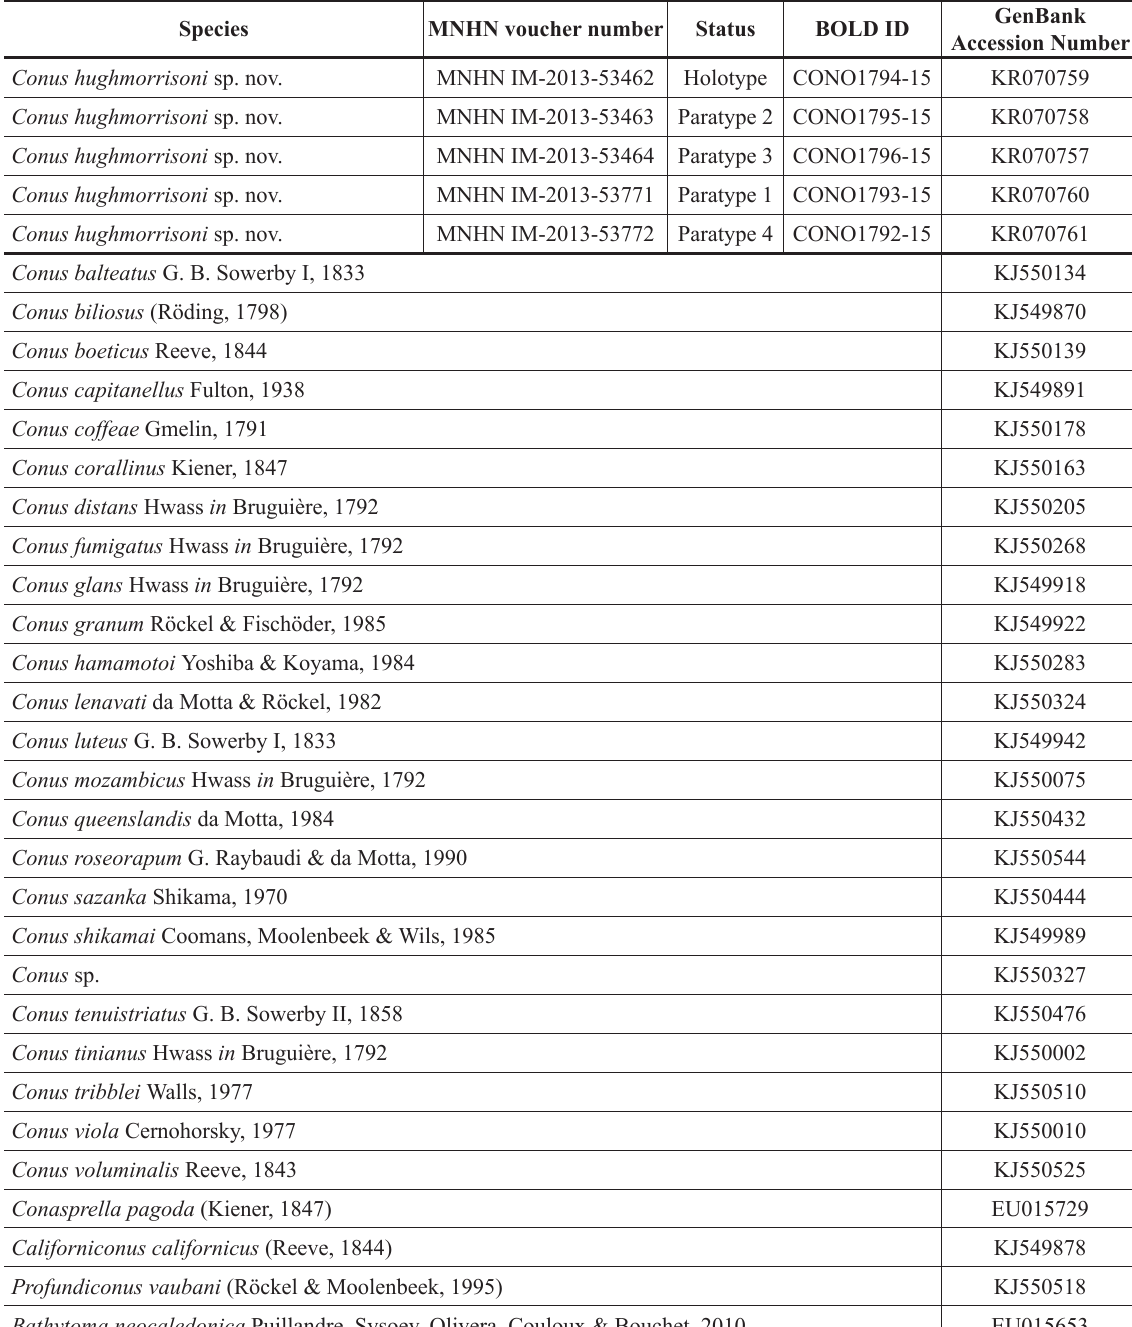
Table 1. List of specimens used in the final dataset for phylogenetic analyses.